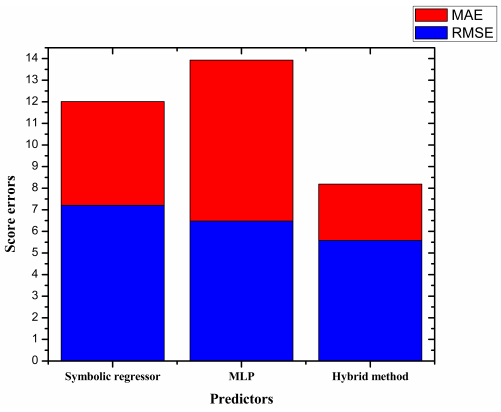
Figure 13. MAE and RMSE Error